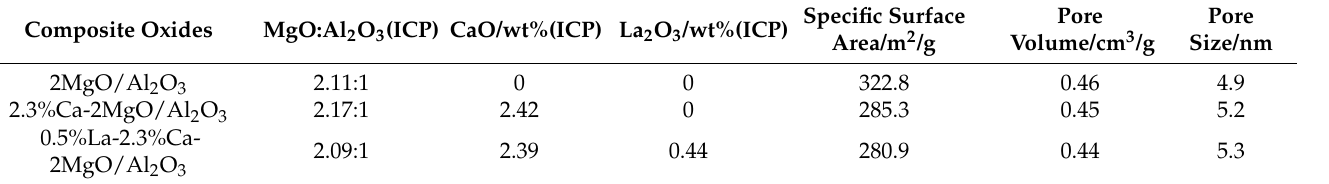
Figure 3. N 2 adsorption–desorption isotherms of composite oxides.